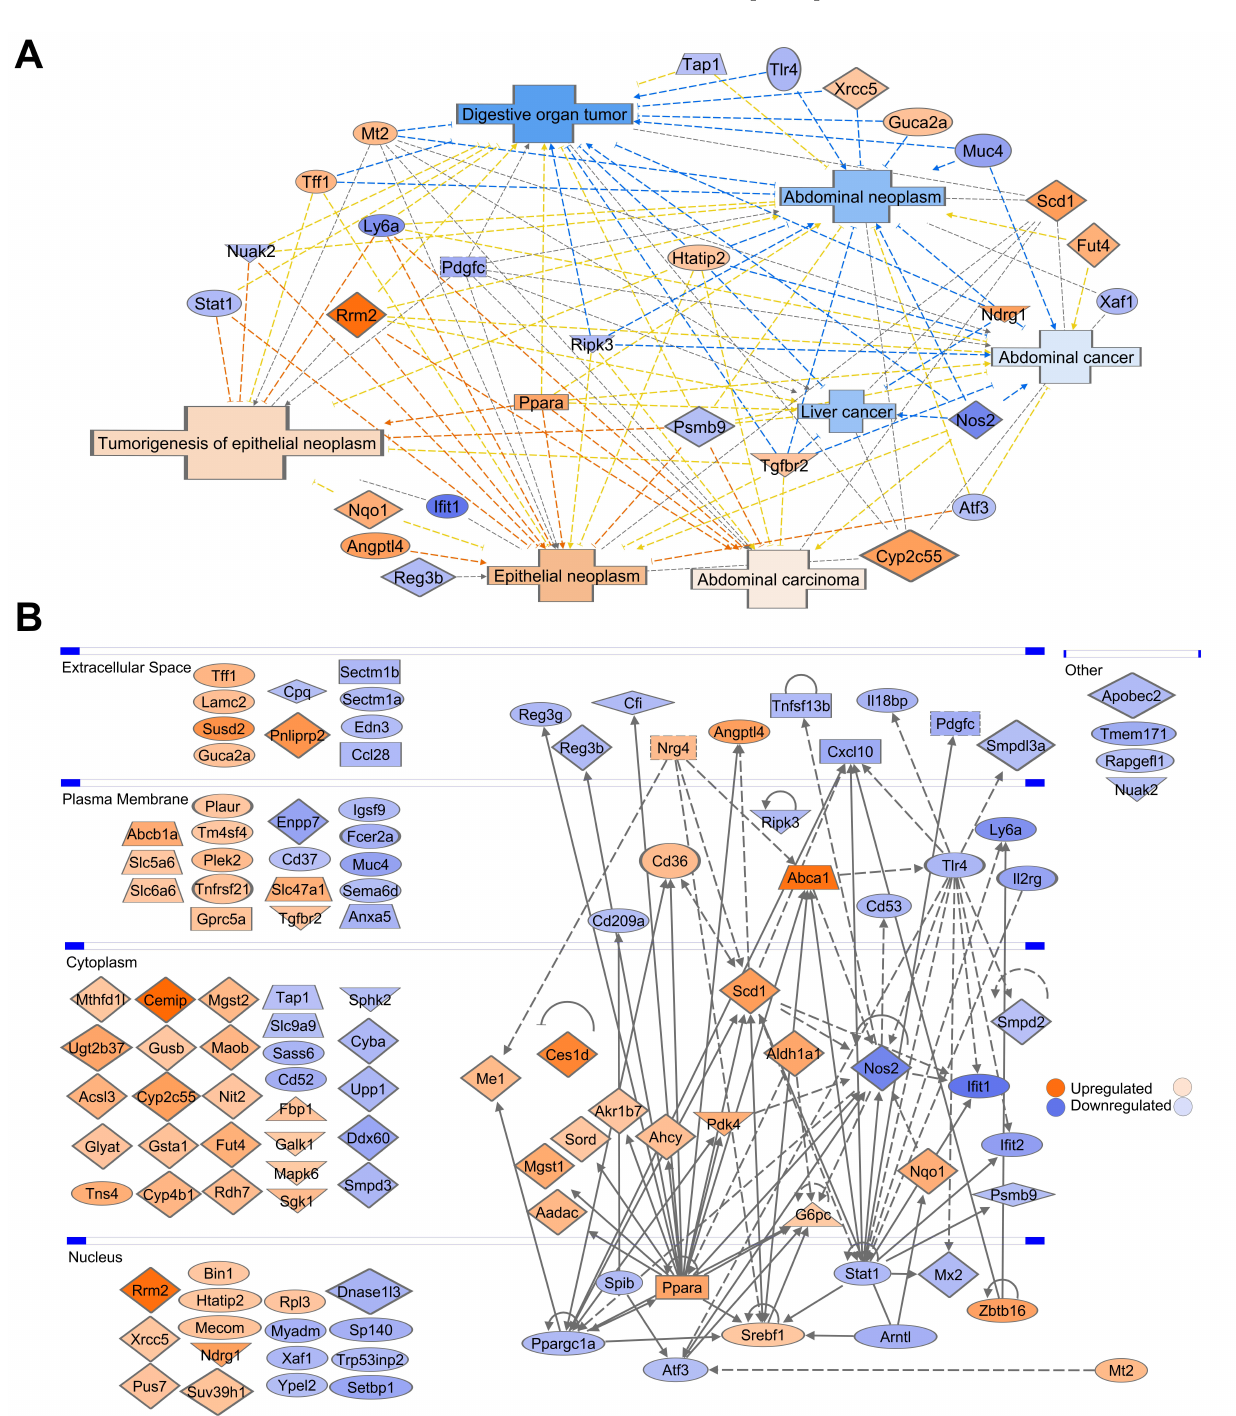
Figure 5. Cancer subcellular network and disease functional annotations. ( A ) A network of 28 proteins based on the functional annotations of the cancer-associated DEGs. ( B ) The network includes 43 connected and 78 non-connected cancer-associated proteins encoded by DM genes distributed across four cellular compartments: extracellular space, plasma membrane, cytoplasm, nucleus. Top hubs include Ppara (25 downstream targets, 6 upstream targets), Stat1 (17 downstream, 12 upstream), Ppargc1a (12 downstream, 8 upstream), Tlr4 (12 downstream, 1 upstream), Scd1 (10 downstream, 7 upstream), and Nos2 (8 downstream, 13 upstream). These hubs account for 54.1% (131/242) of the edge